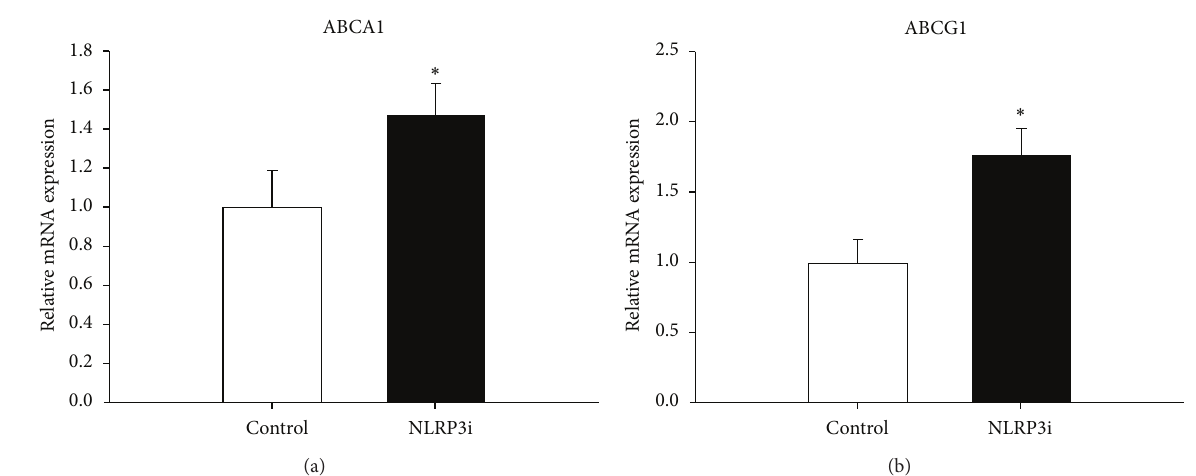
Figure 3: ABCA1 and ABCG1 mRNA expression levels were determined by real-time PCR analyses. Compared with control, mRNA of ABCA1 and ABCG1 increased significantly in aortas of ApoE-deficient mice treated with NLRP3 silencing. ∗ 𝑃 < 0.05 versus control. Values are mean ± SD.